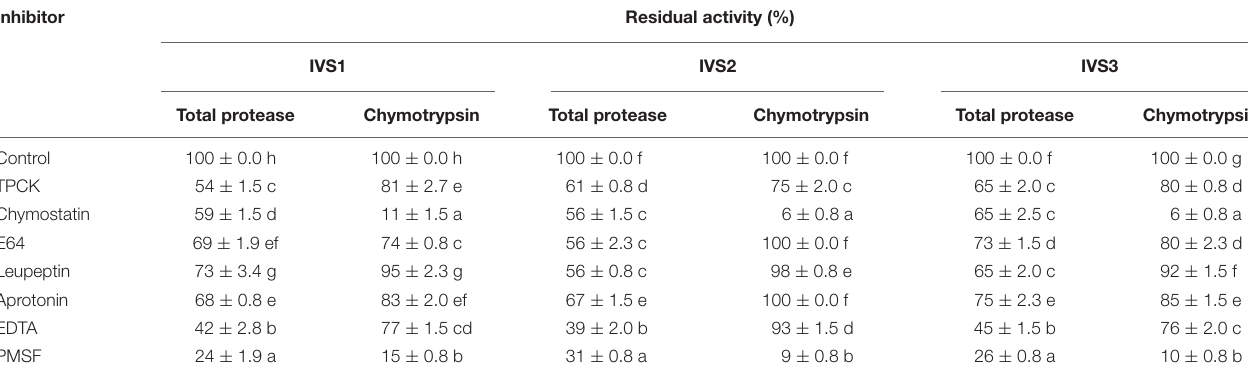
TABLE 4 | Effect of proteases inhibitors on proteases from H. armigera gut bacteria. Inhibitor